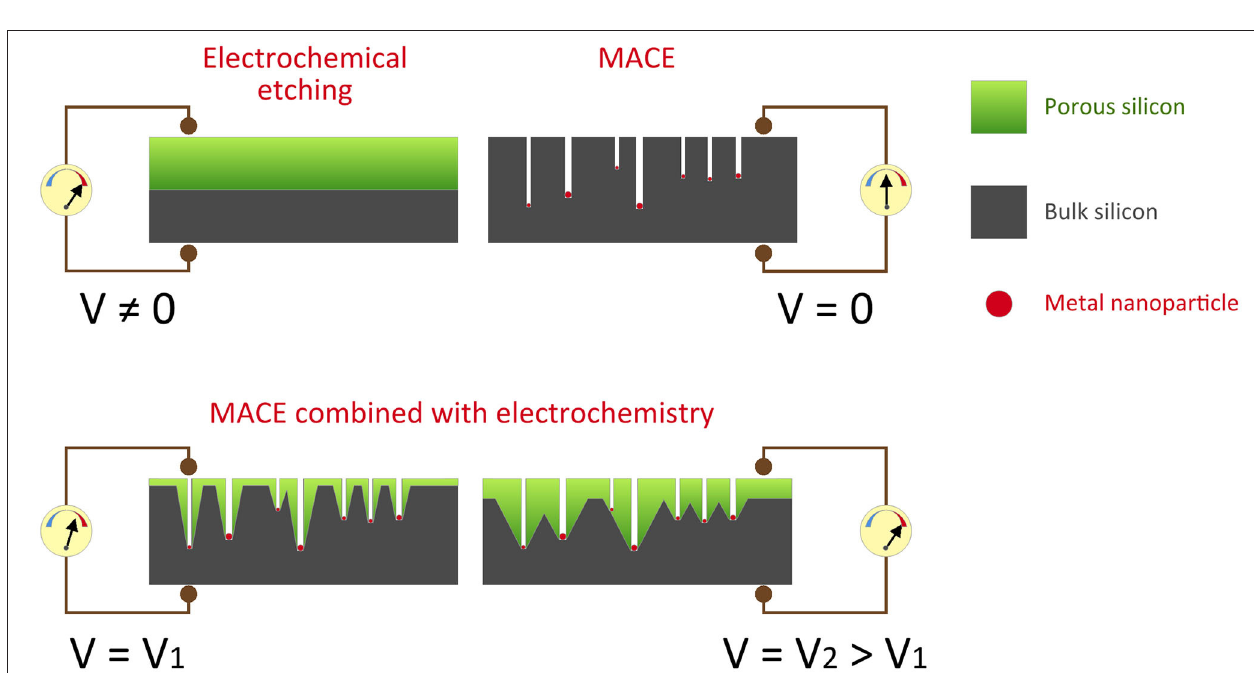
FIGURE 8 | Scheme of the electrochemical anodization and MACE of p-type silicon and their combination for two different applied potentials.